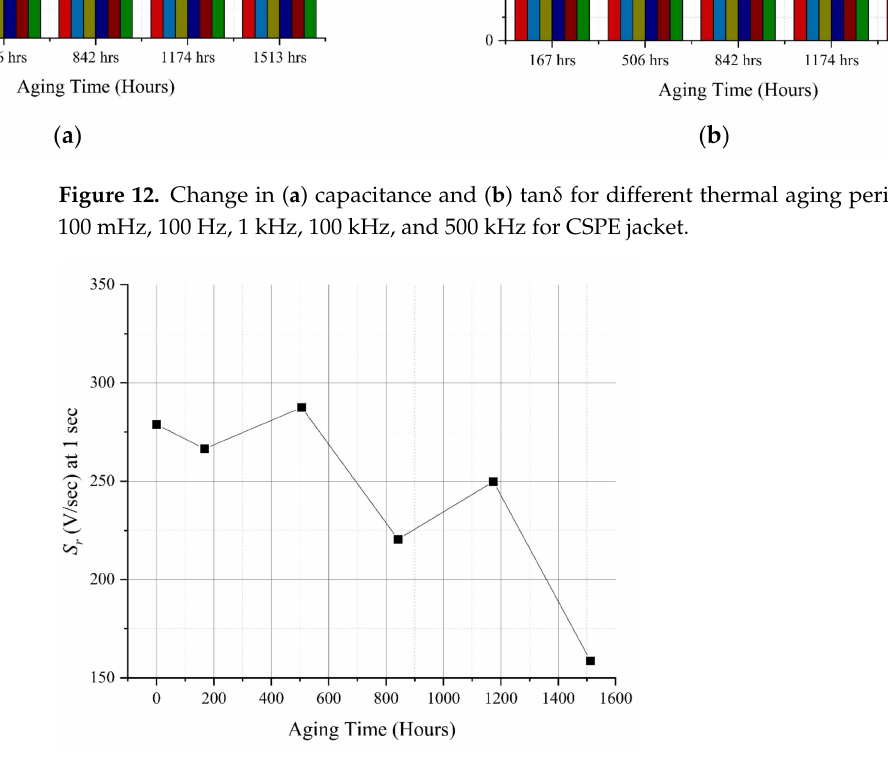
Figure 13. S r at 1 second variation against different thermal aging periods for CSPE